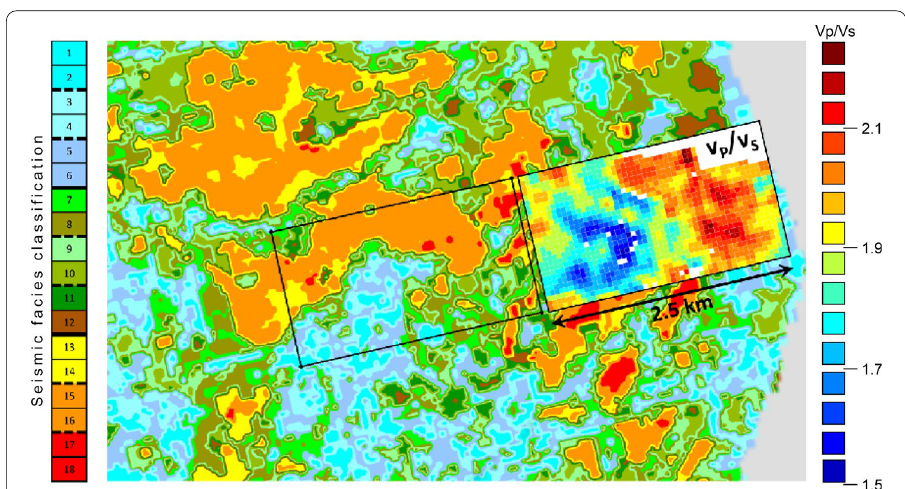
Fig. 11 v p /v s ratio and facies classification of the Upper Jurassic reservoir volume. Seismic facies classification is based on a combination of the following attributes; amplitude, frequency, and similarity in the conventional P-wave volume, after von Hartmann et al. (2019). Classes that show negligible occurrences were combined with the adjacent ones. The black box on the right shows the v p /v s ratio that we derived from the PS data for the location in the left black box. The two independently derived patterns correlate